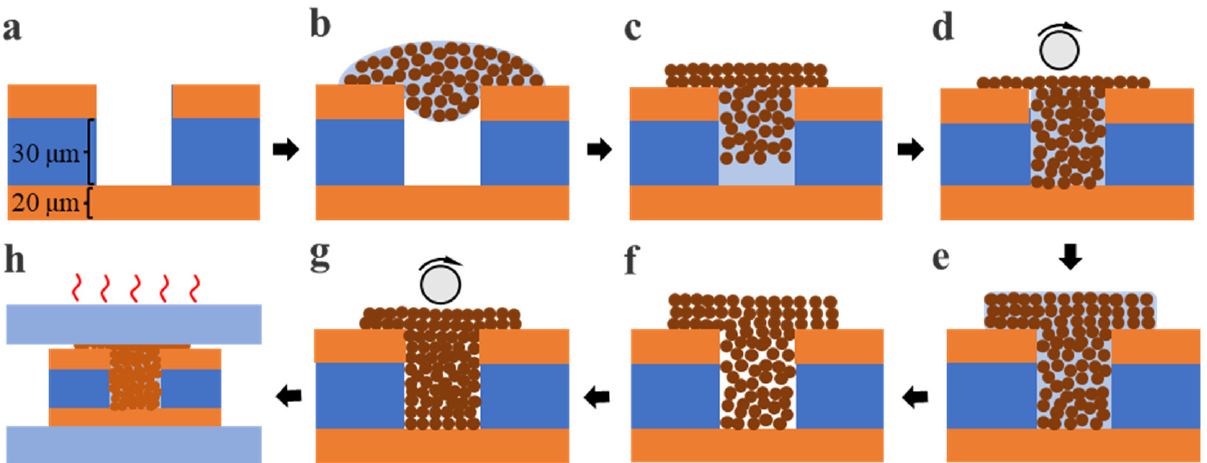
Figure 1. Procedures of the microvia filling process. ( a ) FCCL with a Blind via, ( b ) printing of Cu@Ag NMP paste, ( c ) evacuation, ( d ) roll pressing, ( e ) re-printing of Cu@Ag NMP paste, ( f ) drying, ( g ) roll pressing, ( h ) hot-pressing sintering.